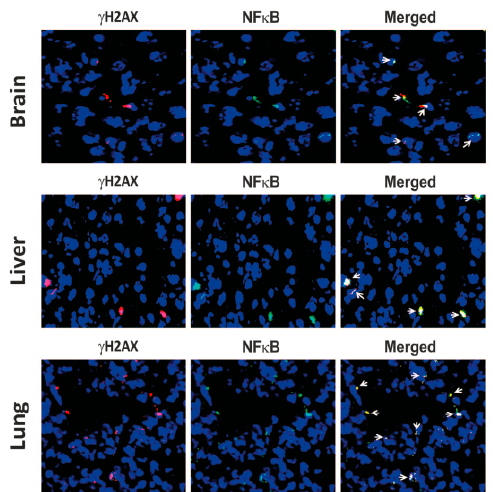
Figure 11. Co-localization of γ H2AX and NF κ B fluorescent signals in vital organs of mice following intravenous injection of Adriamycin treated dying B16-F10 cells. One hundred thousand cells were injected intravenously into mice and animals were killed after 72 h. The vital organs were removed and stained with antibodies against γ H2AX and NF κ B and examined by fluorescence microscopy. Magnification x40. Reproduced from [83].